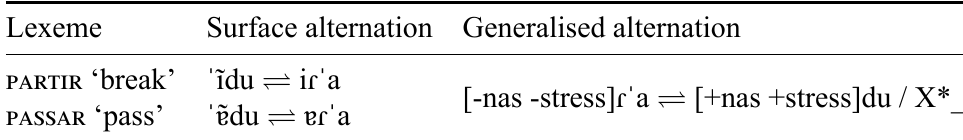
Table 8: Generalisation for phonological alternations ( GER ~ FUT.IND.3SG